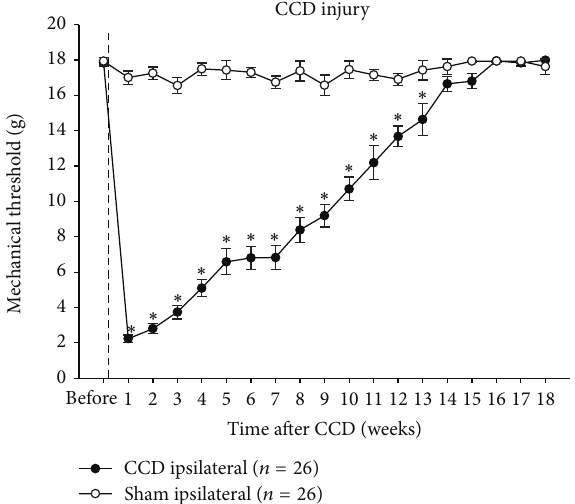
Figure 1: Changes in mechanical sensitivity of hind paws after CCD. A unilateral CCD led to mechanical hypersensitivity of the affected hind paw by showing decreased paw withdrawal thresholds. This hypersensitivitygraduallyreturnedtothenormallevelbypost-CCD week 14. ∗ 𝑃 < 0.05 when compared with sham-operated